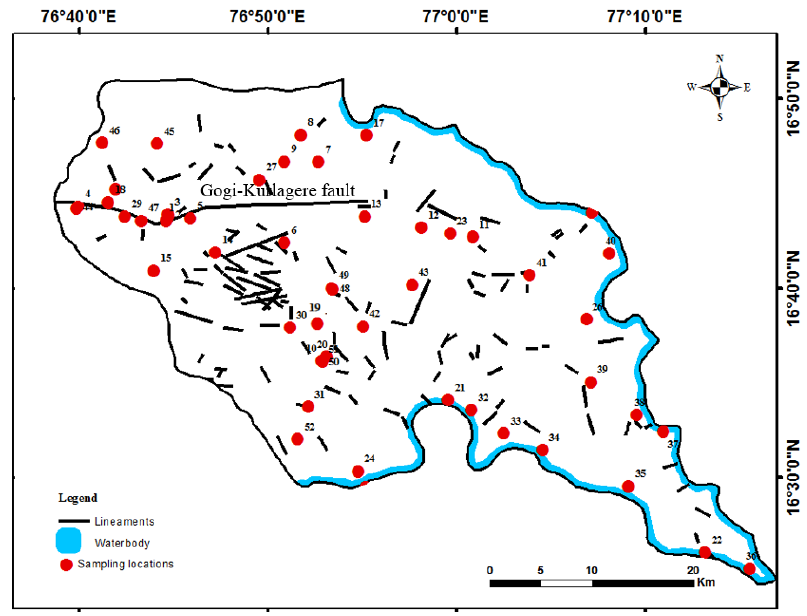
Figure 3. Lineaments and sampling well locations in the study area. Figure 3. L ineaments and sampling well locations in the study area.